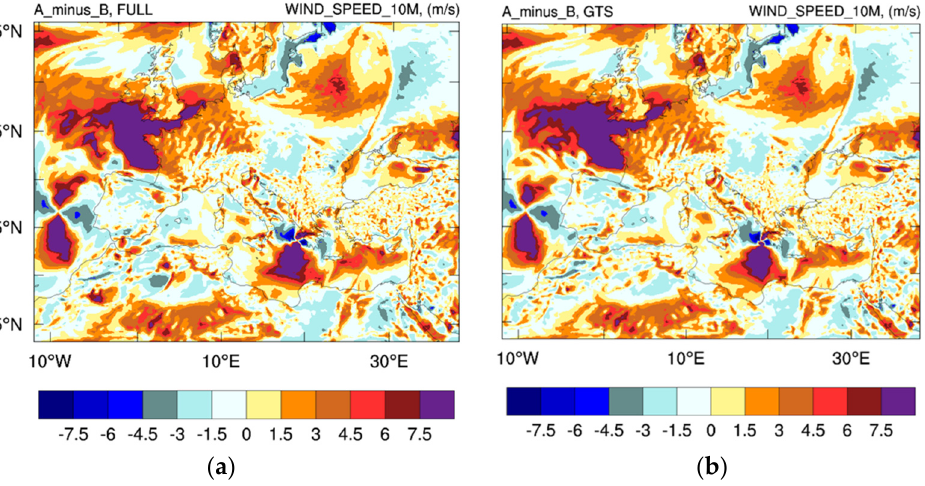
Figure 14. Analysis minus background for the 10 m wind speed (m/s) at 00 on 18 September 2020 for ( a ) the FULL experiment and ( b ) the GTS experiment.